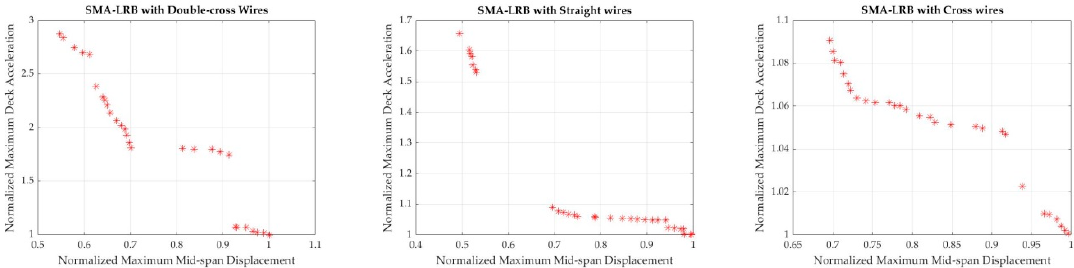
Figure 11. Pareto Front of NSGA-II for the three wire configurations.